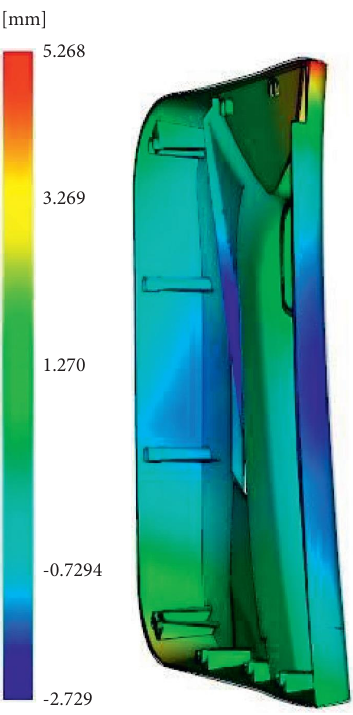
Figure 18: Warpage deformation